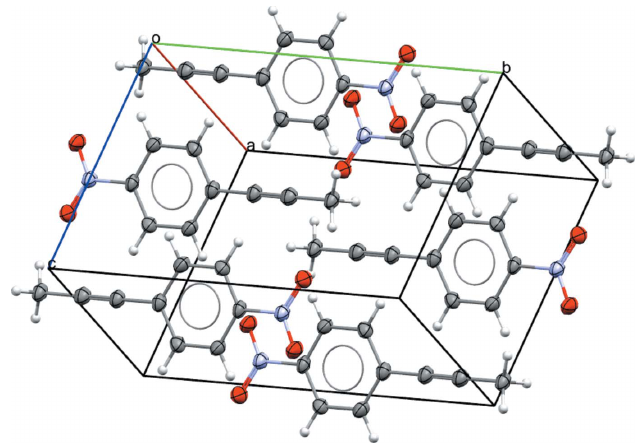
Figure 3 A synthetic scheme for the preparation of title compound 1 .